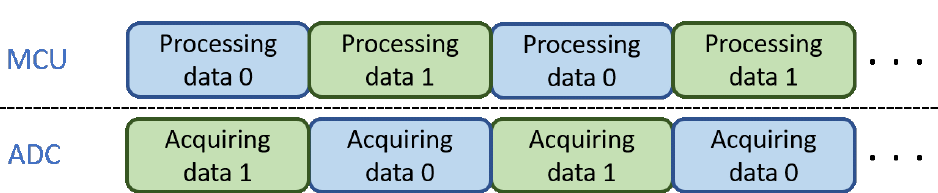
Figure 5. The original time graph with the FIFO.